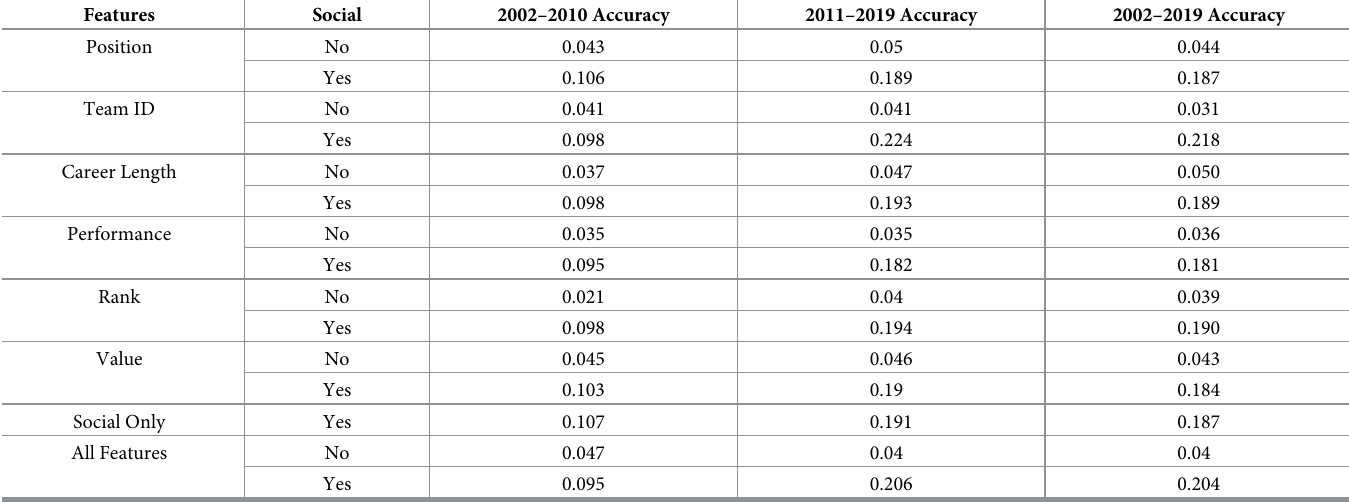
Table 12. Baseball inference accuracy: The inference accuracy using XGBoost for team transition in MLB during the time periods 2002–2010, 2011–2019, and 2002– 2019 is shown.